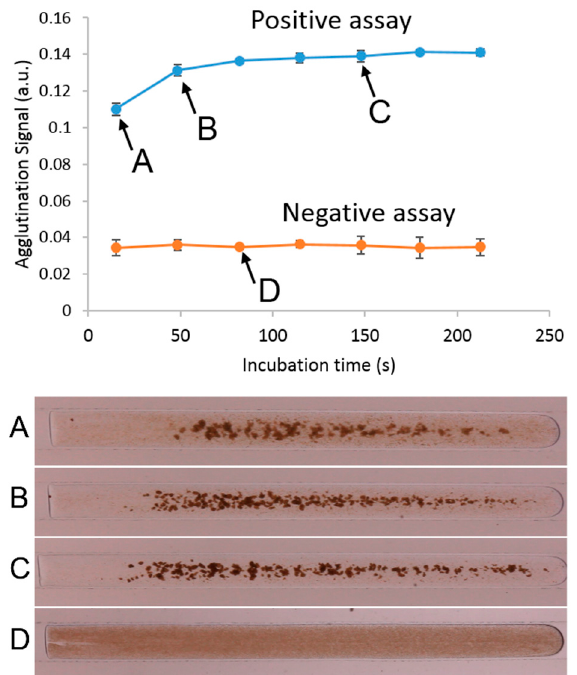
Figure 3. An example of a typical agglutination assay in this system, as the plug travels through the entire length of the tube. Each measurement was taken at 30-cm increments along the channel, located at the PDMS inspection point. This graph shows the progression of the agglutination, with insets showing the frames captured at each window. Points ( A – C ) show a positive agglutination test (2.5 µg/mL biotinylated BSA), and point ( D ) shows a negative test.